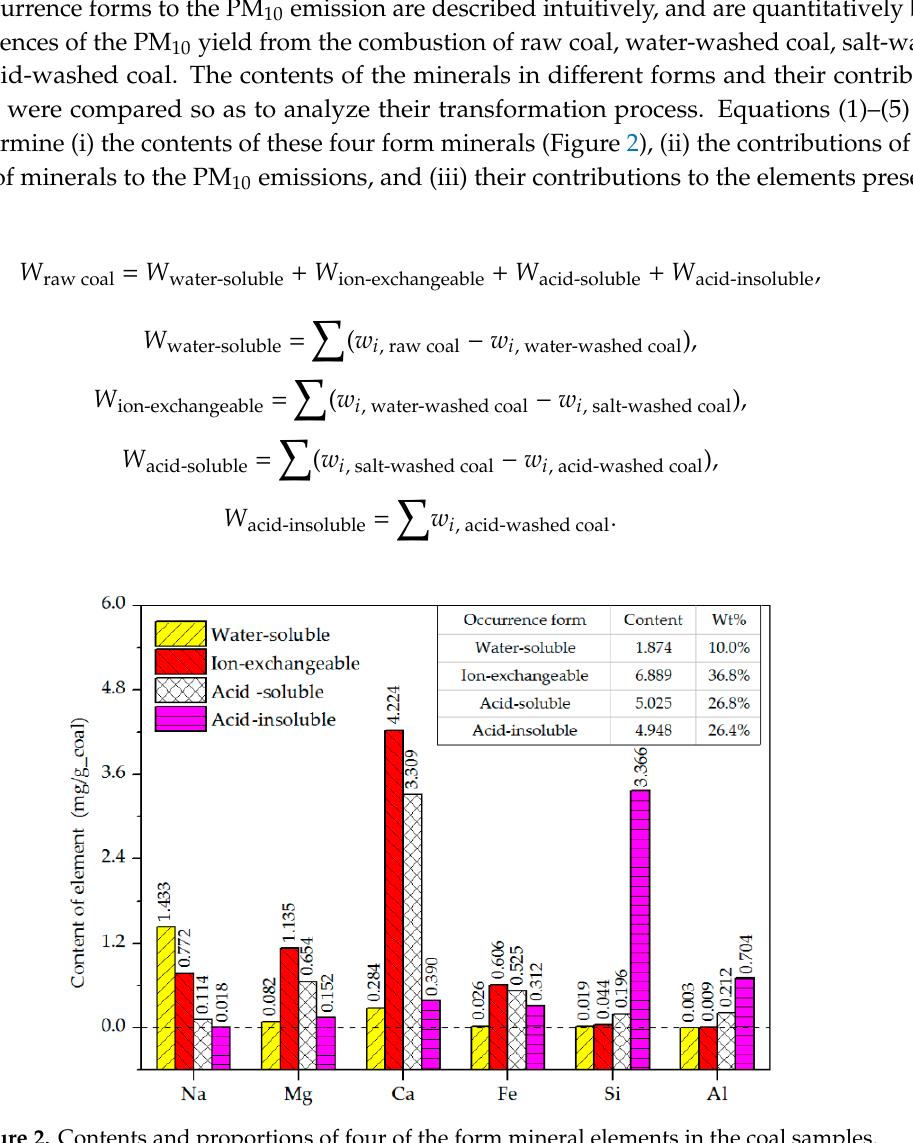
Figure 2. Contents and proportions of four of the form mineral elements in the coal samples.